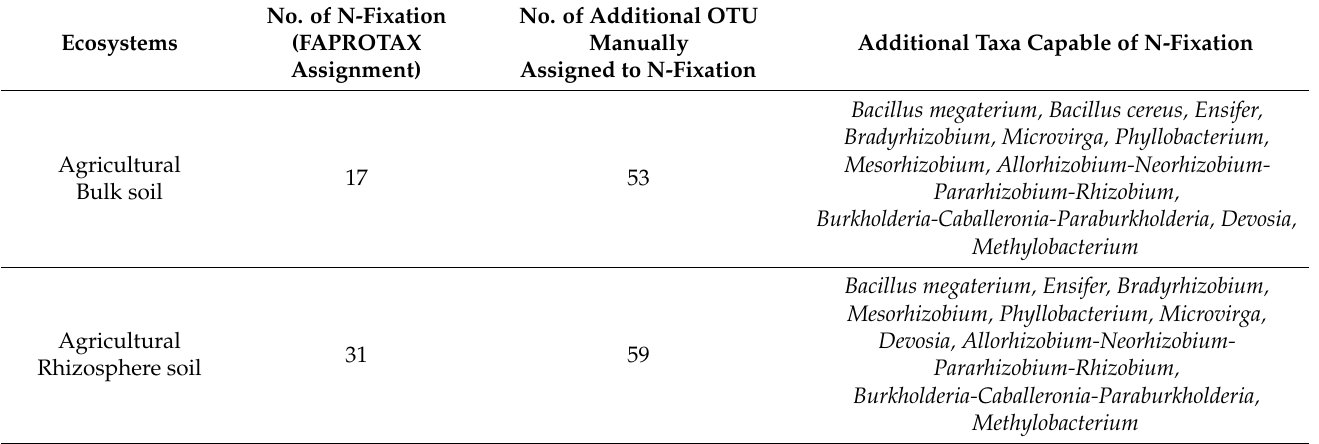
Table 2. Number of OTUs capable of N-fixation before and after adding data from previous studies and the names of additional